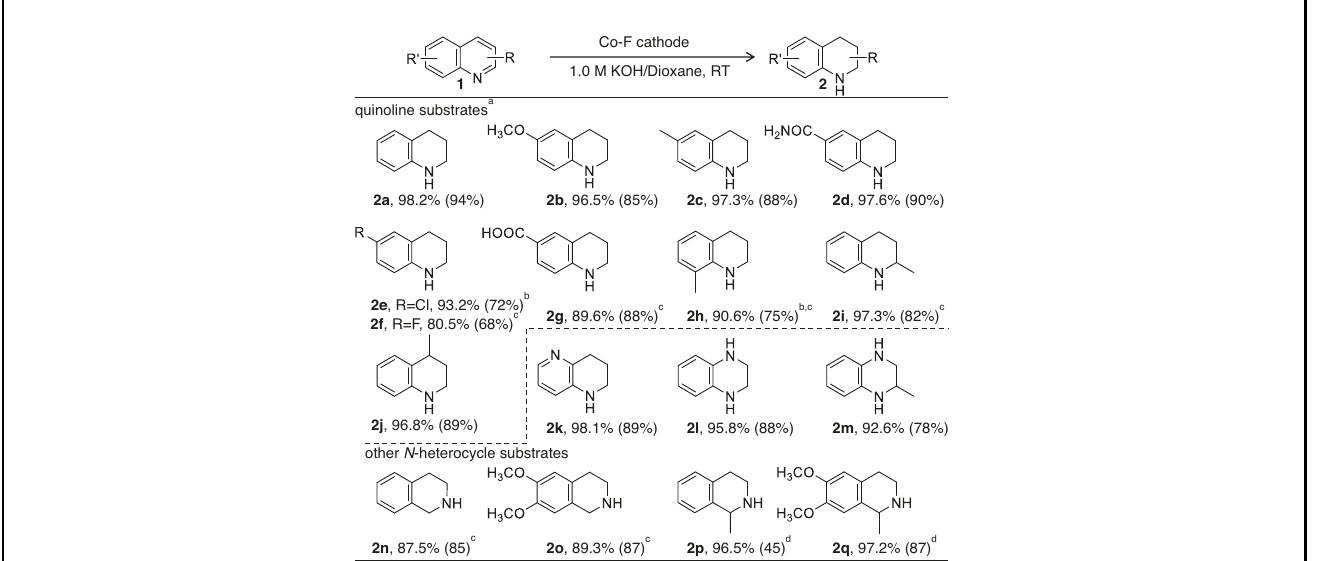
Table 1 | Substrate scope of electrocatalytic hydrogenation of quinolines and other N -heterocycles with H 2 O over the Co-F